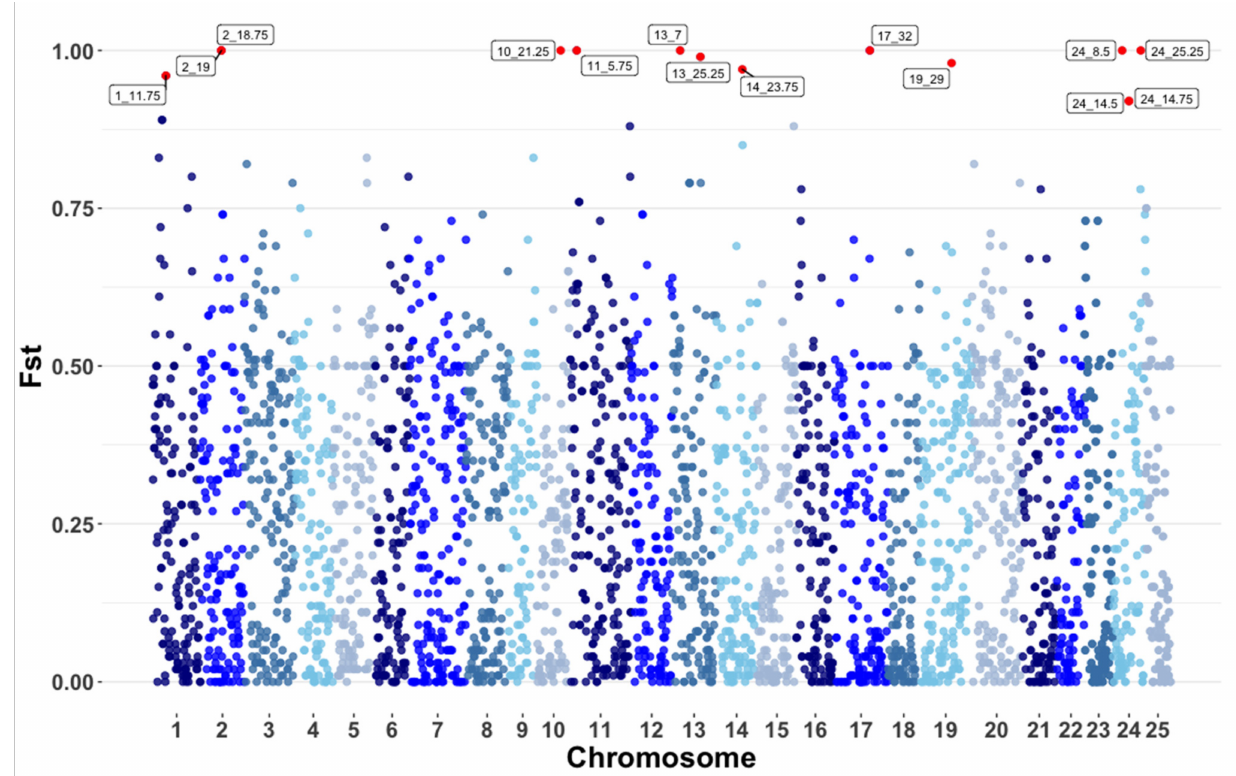
Figure 7. Mean Fst (mFst) values for 0.5 megabase windows with a 50% overlap contrasting the populations of Iowa and Canada. Chromosomes vary in color for easy